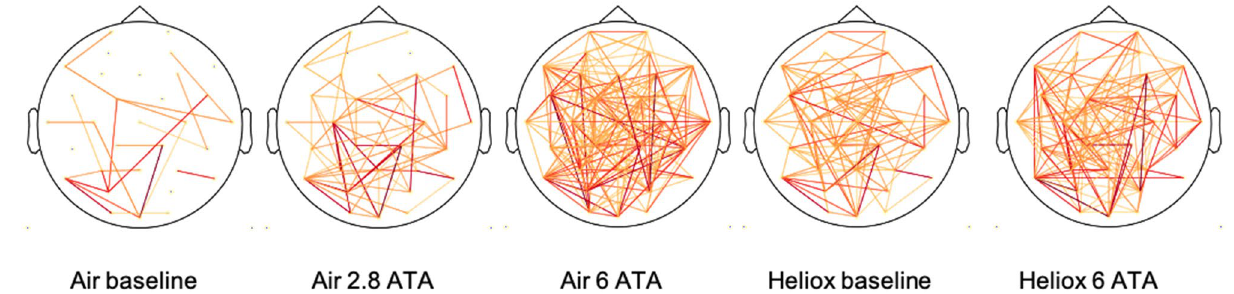
Figure 3. Head plots of binarized mutual information connections for each exposure. Yellow lines are common connections in more than three participants, while orange and red (> 9 participants) depict connections seen in most of the participants.